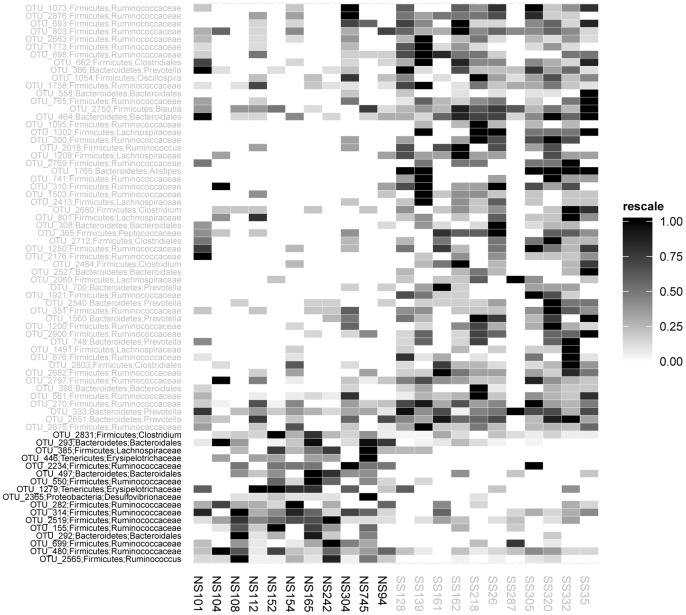
Heat map showing OTUs with a significant differential abundance (p<0.05) between super-shedder (SS; light grey axis labels) and non-shedder (NS; black axis labels) steers.Bacterial taxonomic affiliations are indicated on the left of the heat map at the phylum and genus level except in cases where genus is unknown in which case taxa are summarized at higher ranks. The relative abundance of each OTU is coded as indicated by the scale on the right, with highest number of pyroseqs for each OTUs set as 1.